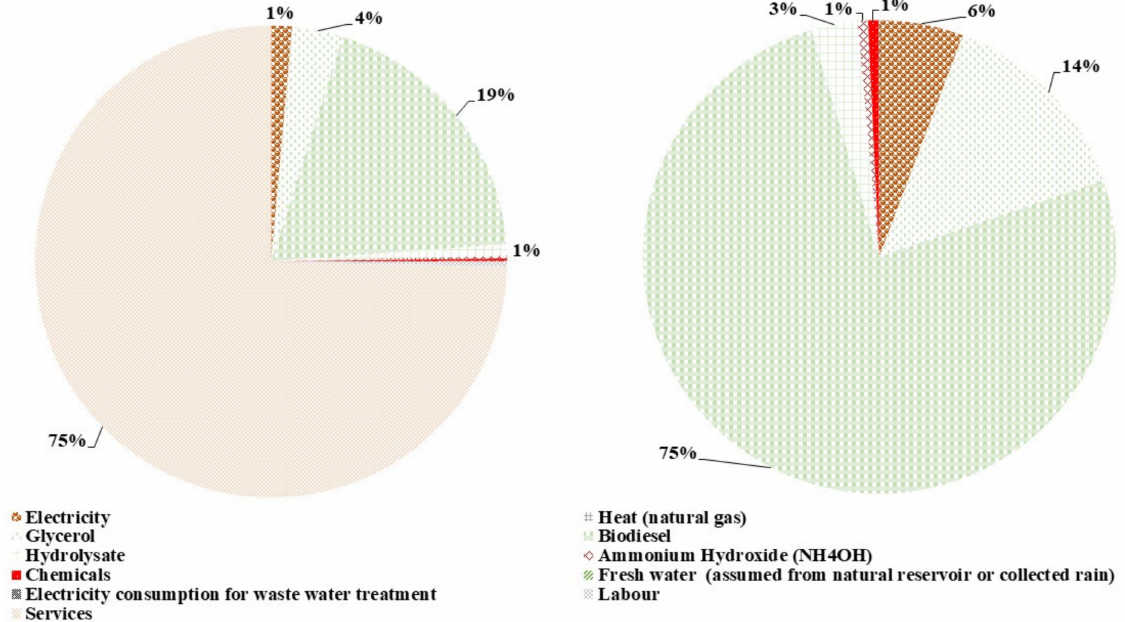
Figure 6. Contribution of input flows to the emergy content of the fermentation process with and without